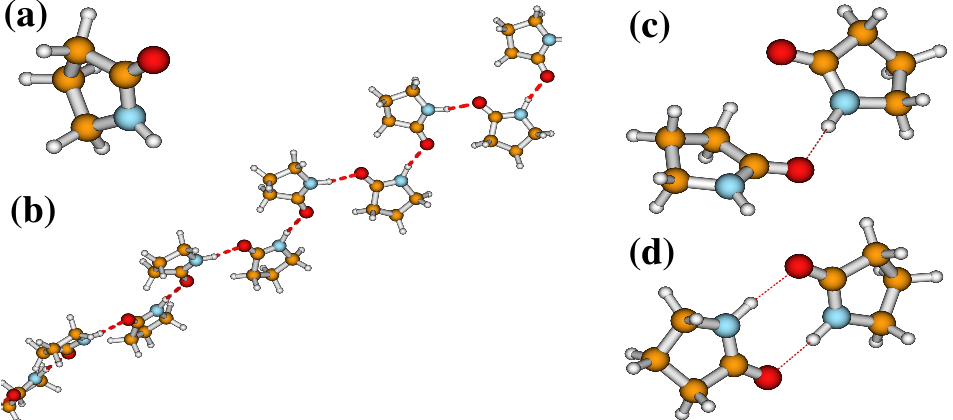
Figure 6. Molecular structure of 2-Pyrrolidinone and its possible hydrogen bonded oligomers. The hydrogen bond is represented by a red dashed line between molecules. ( a ) Monomer, ( b ) single hydrogen-bonded oligomer (SHBO), ( c ) single hydrogen-bonded dimer (SHBD), and ( d ) doubly hydrogen-bonded dimer